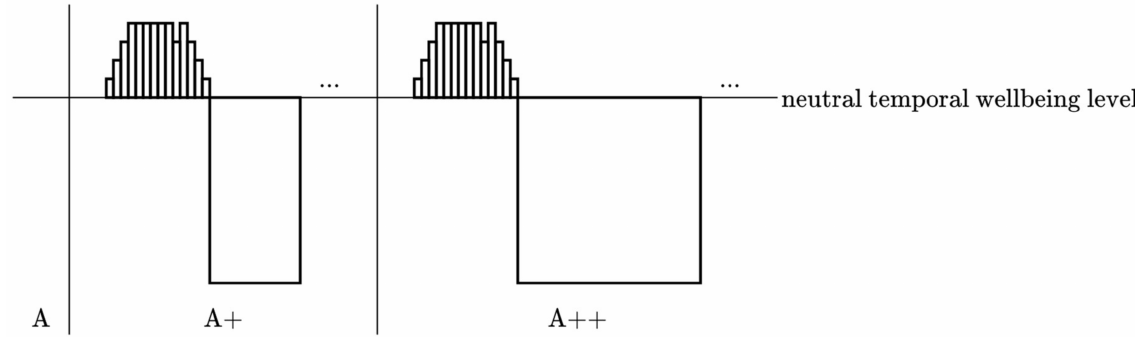
Figure A1. Time-slices of Hitler’s life. Three outcomes are represented, A, A+, and A++. In A, Hitler does not exist. In A+ Hitler exists and his life goes better and worse at different times, but during one long period he experiences a lot of the suffering he deserves, but less than the amount of suffering that he perfectly deserves. This period is represented by the large box in A+ that sits below the neutral temporal wellbeing level. We stipulate that A+ has neutral desert value. In A++, Hitler exists and gets the prolonged suffering that he perfectly deserves, which is more suffering than he gets in A+. The ellipses to the right of the large boxes in A+ and A++ indicate that Hitler’s life continues after his prolonged suffering. We can assume that the part of his life after his deserved suffering is good for him and that his life is good for him overall. We stipulate that the parts of Hitler’s life that are not represented by the boxes in Figure A1 do not make a relevant difference to how A, A+, and A++ compare. In other words, apart from the contribution that Hitler’s deserved suffering makes to the value of these outcomes, other things are equal. This version of the desert-neutrality paradox has the same structure as the version presented in Section 4.2. Hitler’s non-existence is neutral with respect to desert. Hitler’s existence in A+ is a neutral addition. Hitler’s existence in A++ is better with respect to desert than his existence in A+, since in A++ he gets the amount of suffering that he perfectly deserves, which is better than his getting less than that amount. But is A++ really better than A with respect to desert? If it is, then Hitler coming into existence and experiencing the suffering he perfectly deserves makes an outcome better, other things being equal. This gives retributivism an unpalatably sadistic